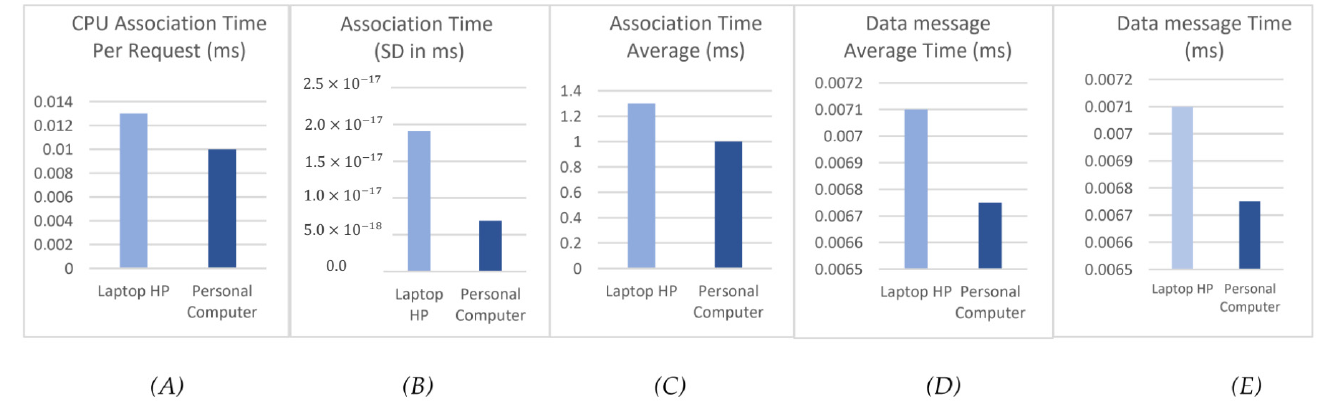
Figure 3. Evaluation results: ( A ) CPU Association Time Per Request (ms), ( B ) Association Time (SD in ms), ( C ) Association Time Average (ms), ( D ) Data message Average Time (ms), and ( E ) Data message Time (ms).